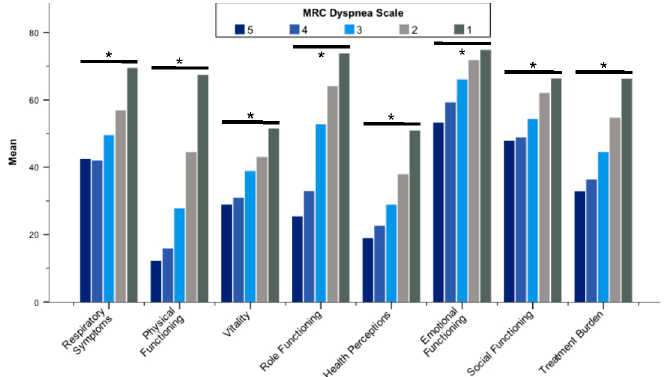
Figure 1. Mean Quality of Life Questionnaire-Bronchiectasis scores stratified by the MRC dyspnea scale. Abbreviation: MRC, Medical Research Council. * p < 0.001. Differences between groups were assessed by the Kruskal–Wallis test.